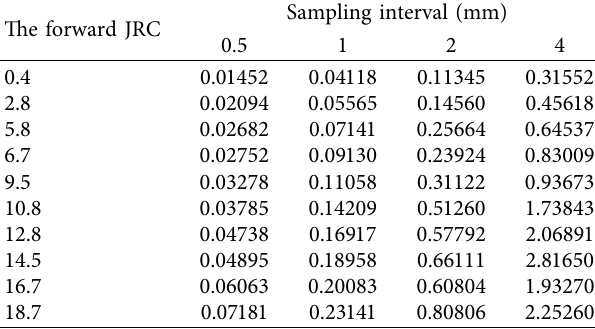
Table 5: The fitting relationship between Sa and JRC under dif- ferent sampling